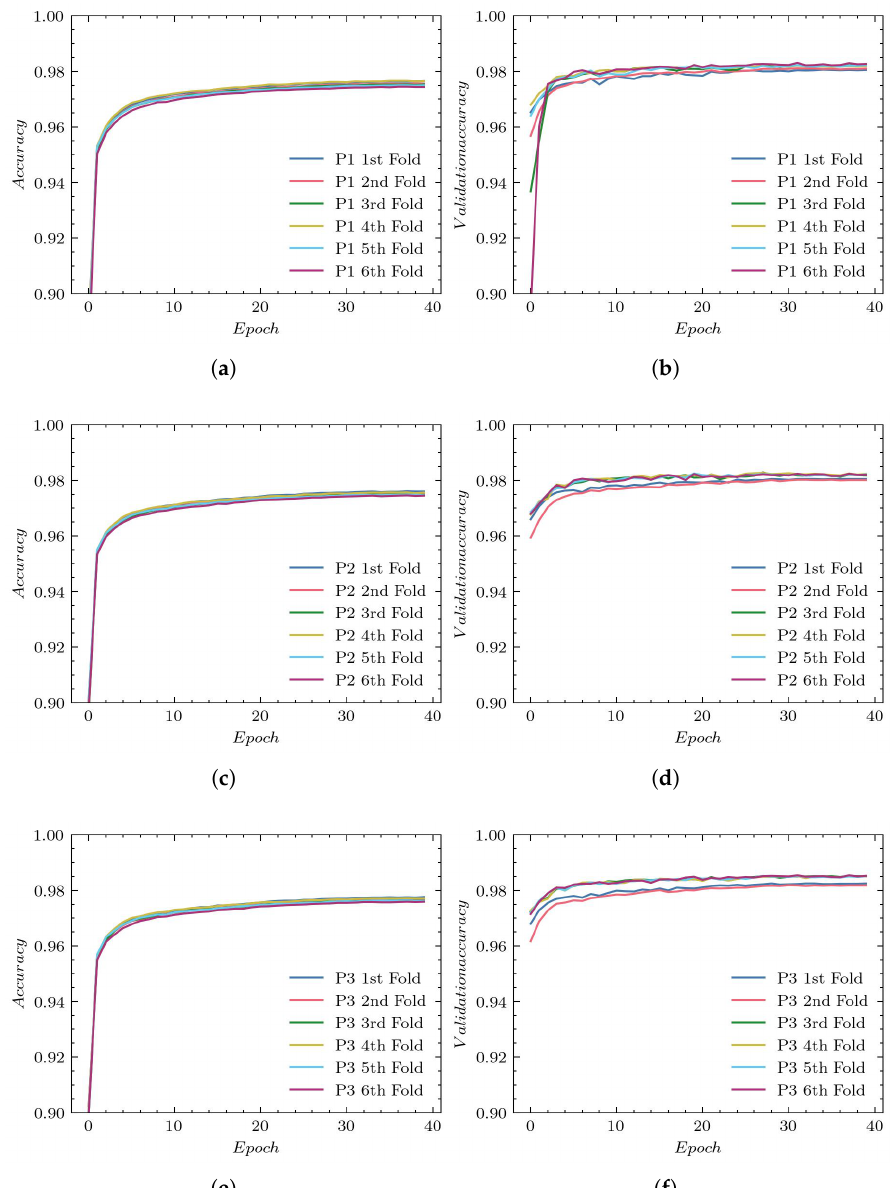
Figure 14. Accuracy plots for FR-UNet architecture: ( a ) training using P1, ( b ) validation using P1, ( c ) training using P2, ( d ) validation using P2, ( e ) training using P3, and ( f ) validation using